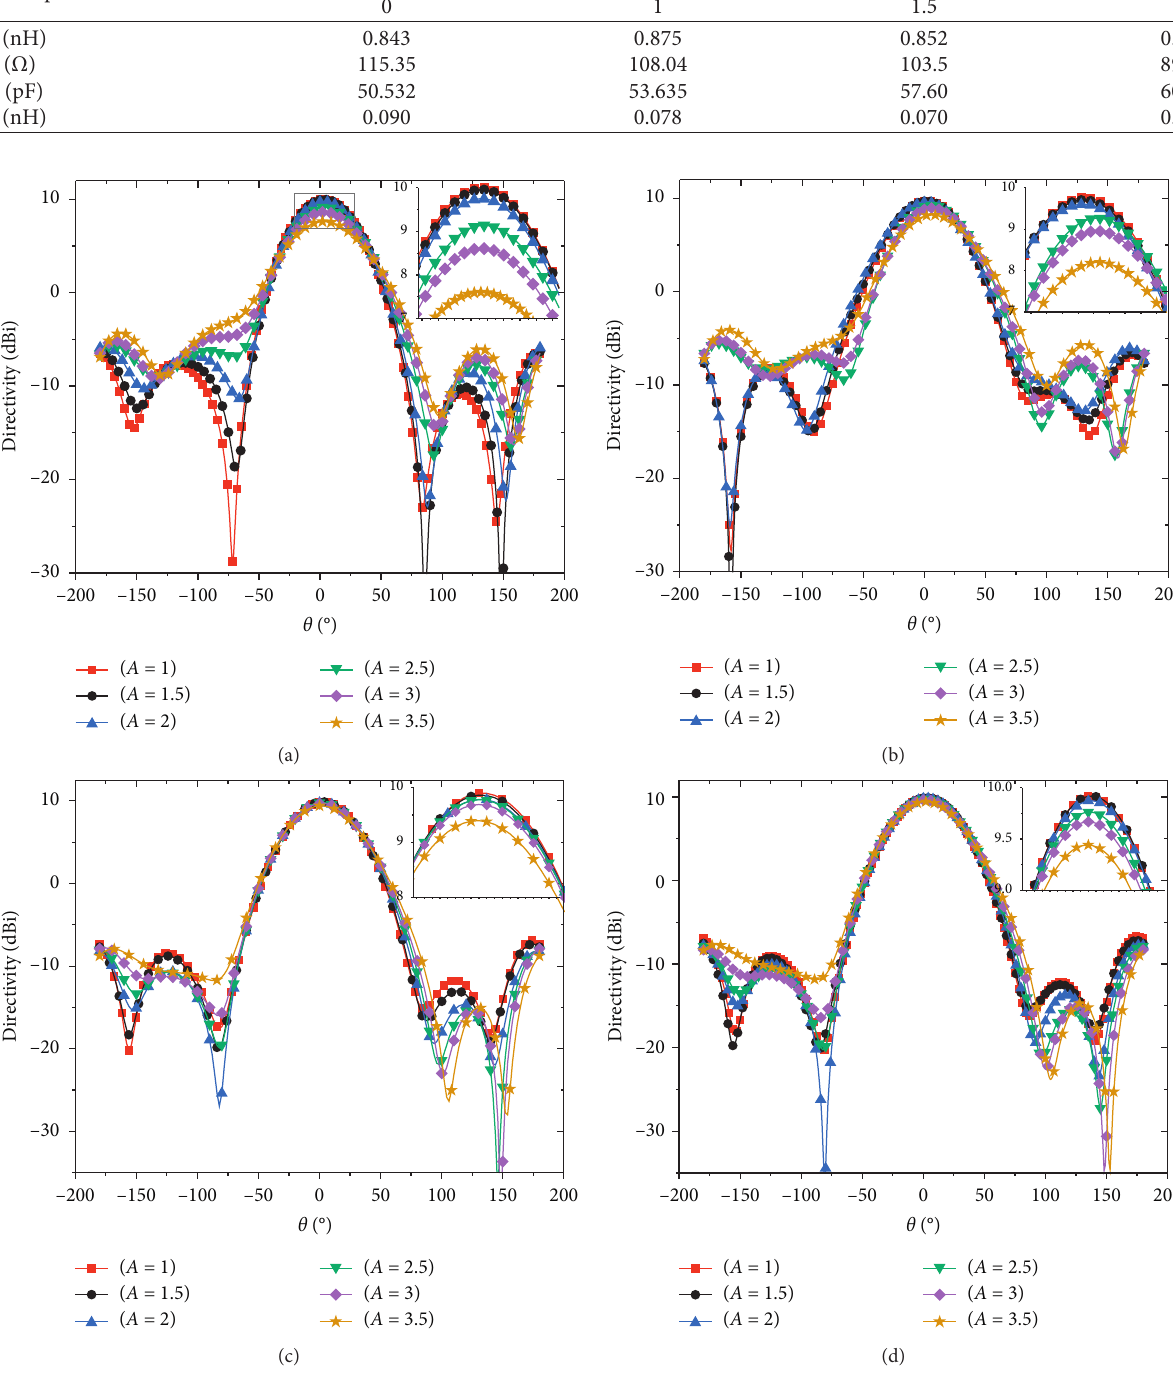
Figure 11: The E-plane radiation patterns change with deformation amplitude A . (a) Case a, (b) case b, (c) case c, and (d) case d.